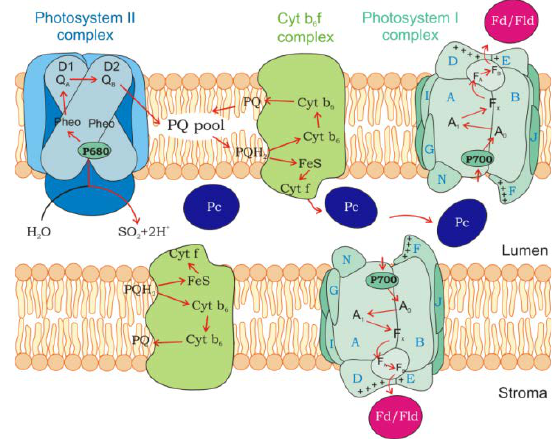
Fig. 2. Schematic view of photosynthetic electron transport processes. Two thylakoid membranes and the luminal space between them are shown. Multi-protein complexes Photosystem 1, Photosystem 2, and cytochrome bf are embedded in the membrane. Molecules of mobile electron carrier protein plastocyanin (Pc) diffuse in the lumen. The arrows denote electron transport. The connection with the Calvin cycle is carried out by mobile carriers Fd (or